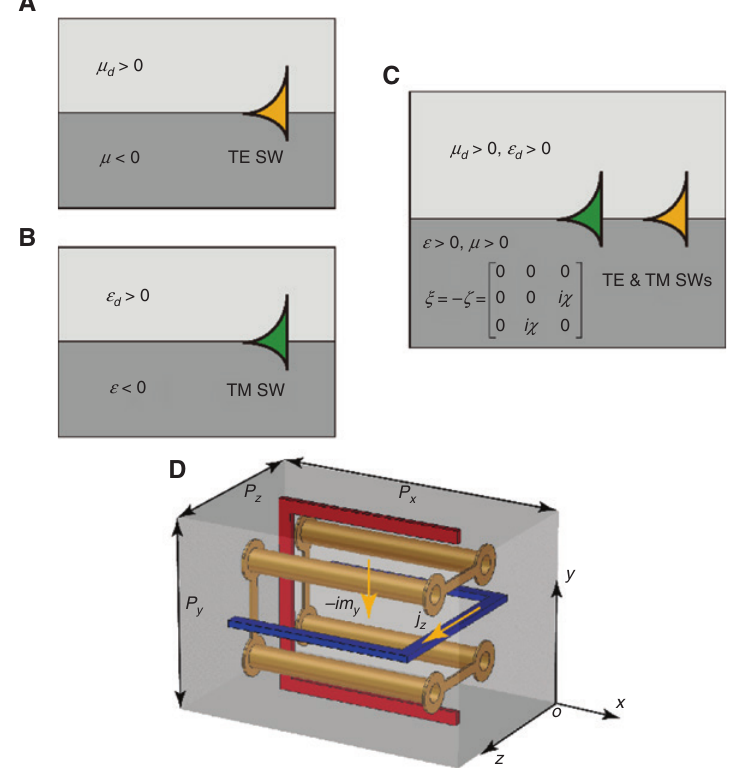
Figure 1: Schematic illustration of three types of interface with corresponding surface wave and one realistic model of bianisotropic